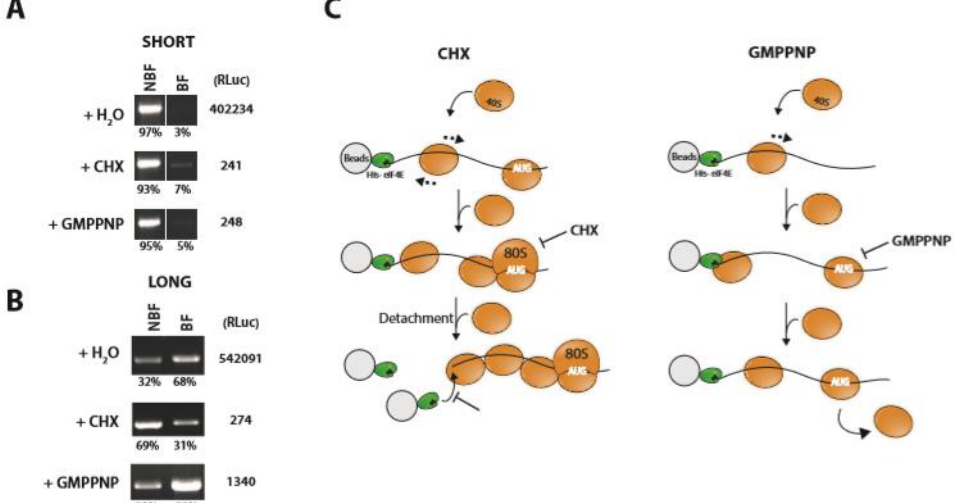
Figure 3. Solid phase expression from immobilized short and long TLs: impact of the drugs cycloheximide and GMPPNP. ( A ) Capped RLuc reporter transcripts with a short 5 (cid:48) TL (8 nt) were immobilized via HIS eIF4E as outlined in Figure 2. Beads were used to program cell extracts containing either H 2 O, cycloheximide to trap the 80S or GMPPNP to trap the 43S. RNA in the BF and NBF fractions was detected by RT-PCR. The percentage of the total in each fraction are indicated as is the